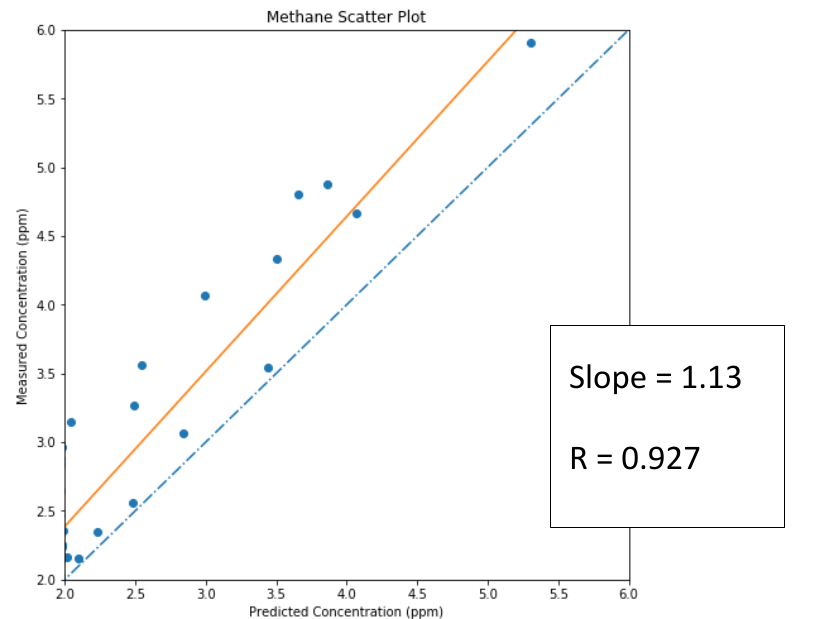
Figure 7. Scatter plot of measured methane concentrations versus modeled concentrations for 5 June 2021, 10:24 a.m. to 10:39 a.m. R denotes the correlation coefficient. The (orange) regression and (blue) 1:1 lines are also displayed.